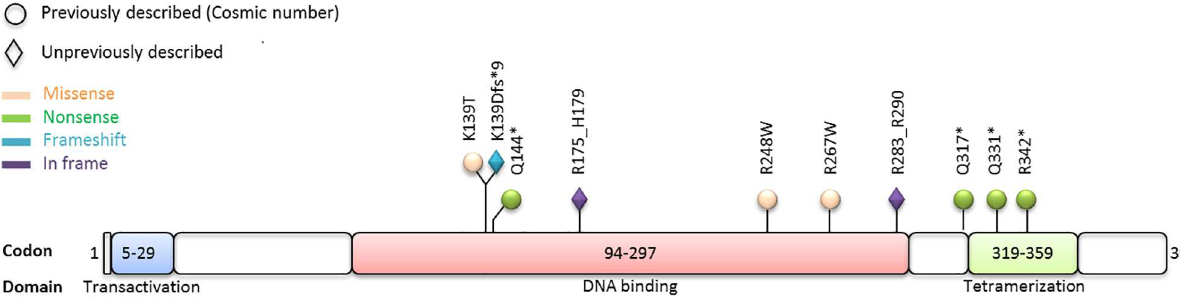
Fig 1. Schematic representation of somatic mutations identified in TP53 by targeted deep sequencing (n = 35). Mutation sites were marked and amino acid changeswere indicated. Colors and shapes indicatedthe kind of mutation and the presencein the COSMIC